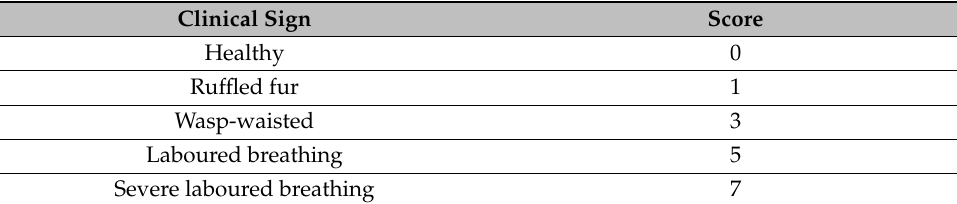
Table 2. Scoring system for clinical observations.